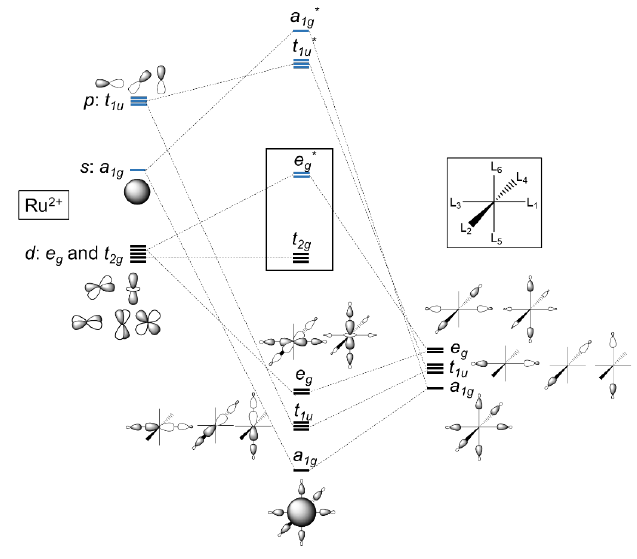
Figure 3. The interaction diagram of Ru 2+ ions with six identical σ -ligands in an O h symmetry point group. Bonding interactions of symmetry-adapted linear combination of ligand donor orbitals with metal orbitals are presented. Black and blue bars represent doubly filled and empty orbitals, respectively.